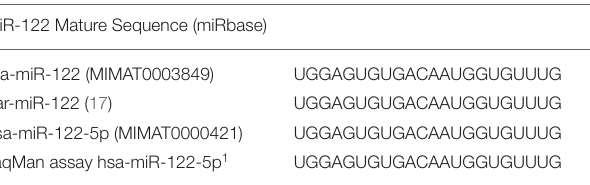
TABLE 3 | Live weight, average daily gain (ADG), dry matter intake (DMI) and feed efficiency (Gain:Feed) for the steers fed concentrates over